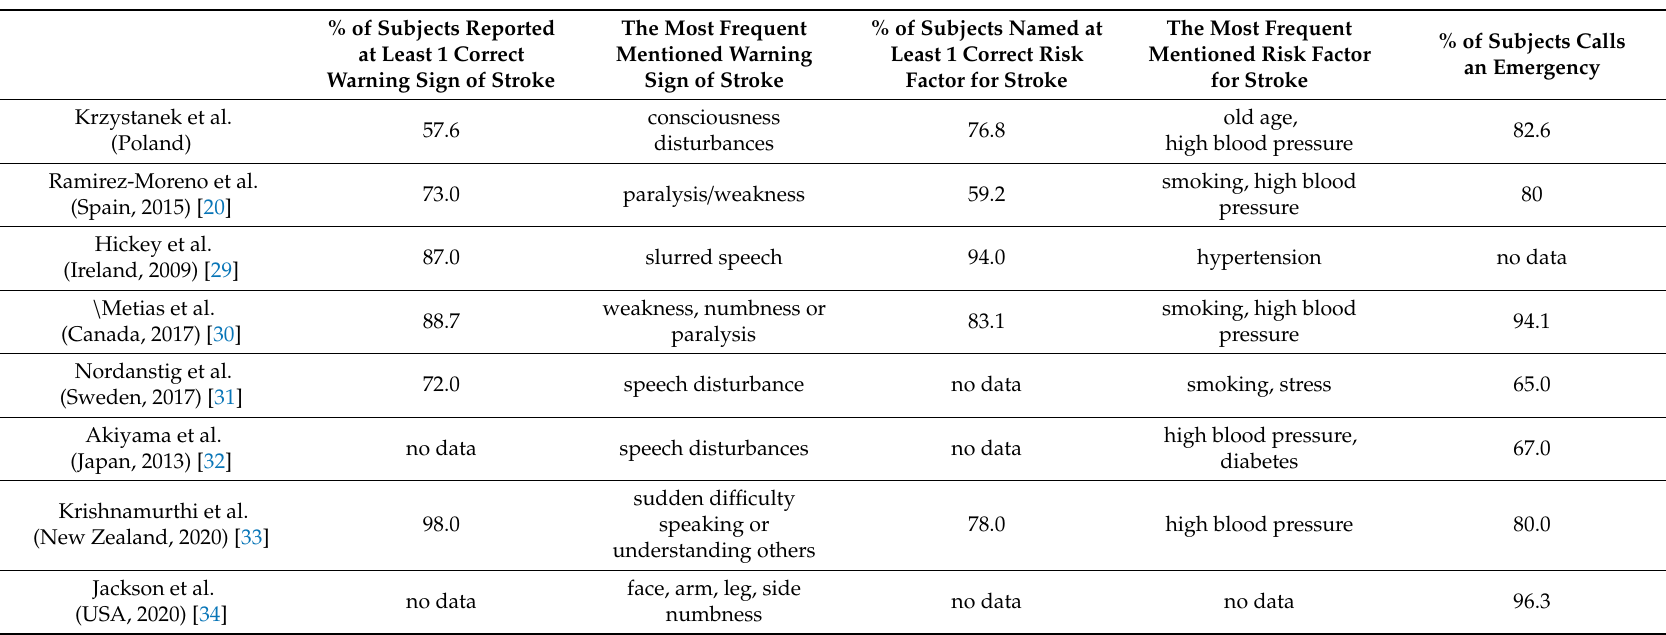
Table 8. Some data regarding stroke awareness received from di ff erent